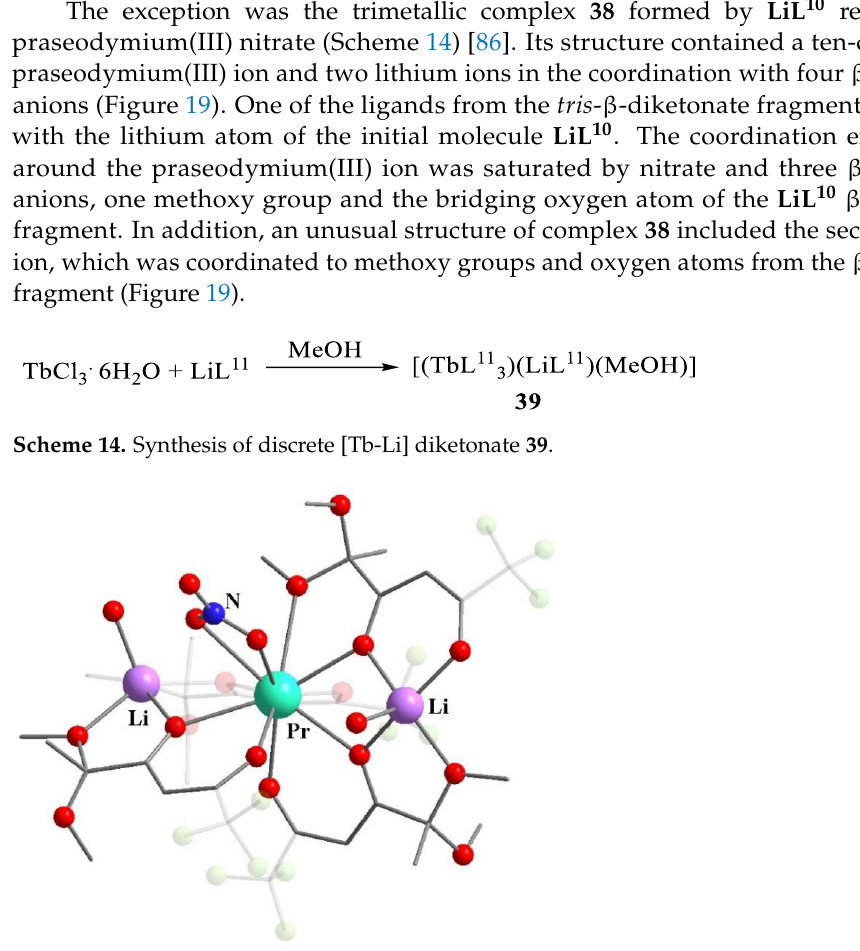
Figure 19. Molecular structure of 38 [86]. Hydrogen atoms have been omitted, CF 3 groups and one ligand molecule are transparent for clarity. The cif has been retrieved from CCDC. CCDC numbers is 2031103. Figure 20. Molecular structure of 39 [89]. Hydrogen atoms have been omitted, C 2 F 5 groups are trans- parent for clarity. The cif has been retrieved from CCDC. CCDC numbers is 2011088.